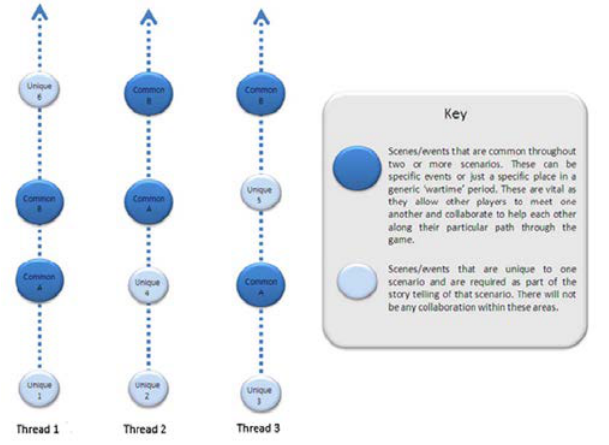
Figure 3. Common and unique plot points in